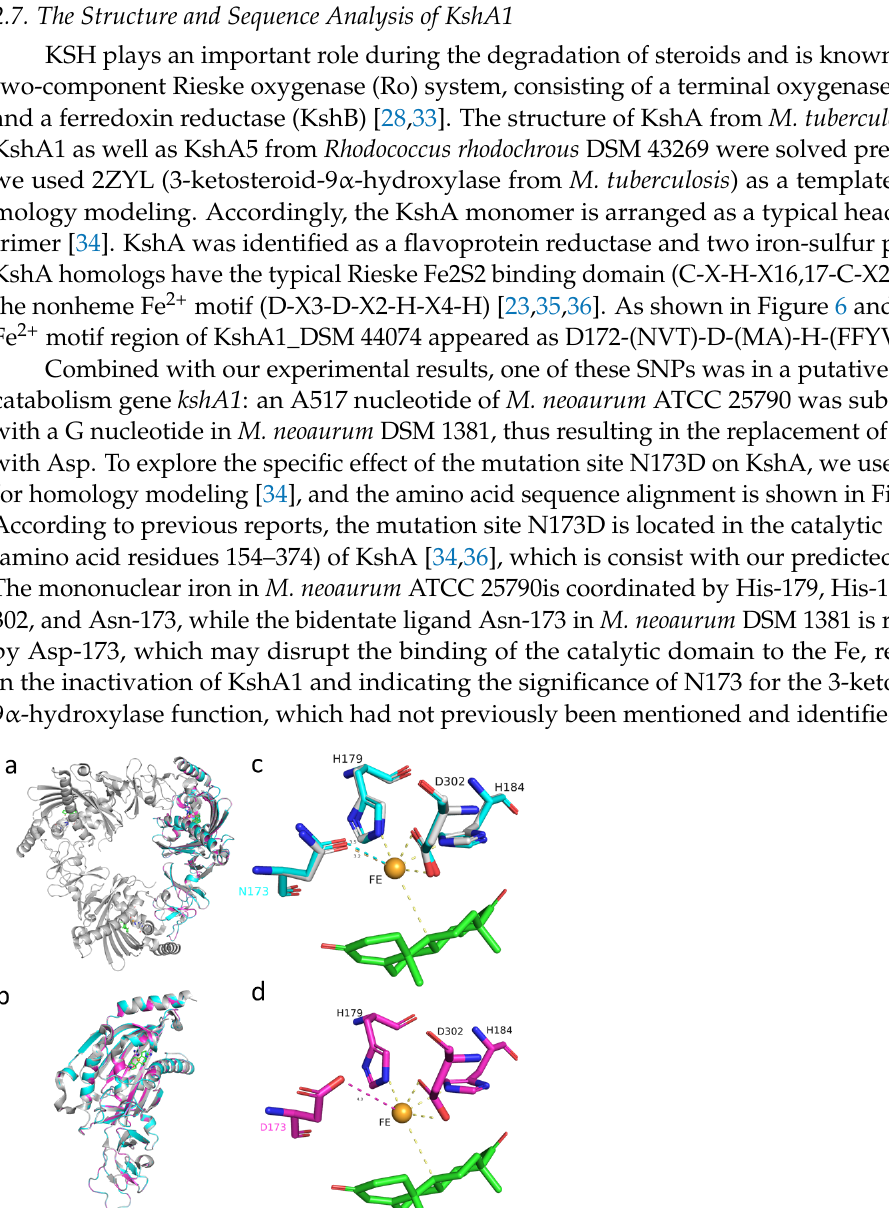
Figure 5. Structural model of Hsd4A. ( a ) DSM 1381_Hsd4A, aquamarine; ATCC 25790_Hsd4A, light magenta; ( b ) DSM 1381_Hsd4A, gray, 171E and NAD+ shown in sticks; ( c ) DSM 1381_Hsd4A, gray, K171 and NAD+ shown in sticks.